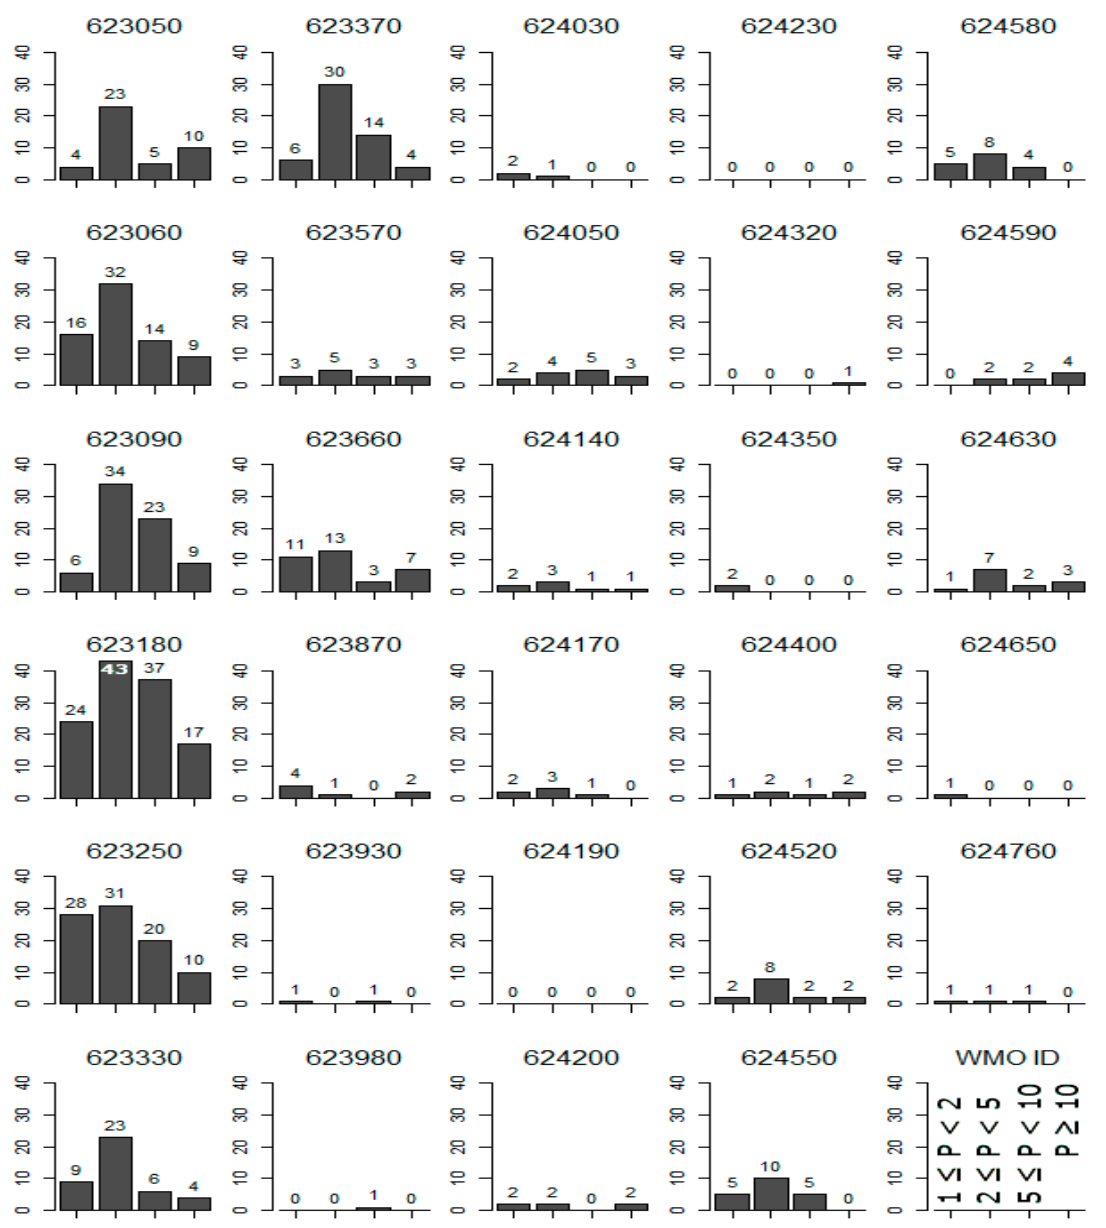
Figure 3. Bar graphs representing the count of rainfall events of the light, low–moderate, high–moderate, and heavy rainfall intensity classes at each rainfall station. Table 7. The total count of events detected at observed rainfall stations for each rainfall intensity class.